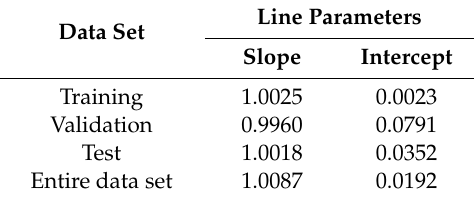
Table 4. Regression model parameters performed on the ANN predicted values.